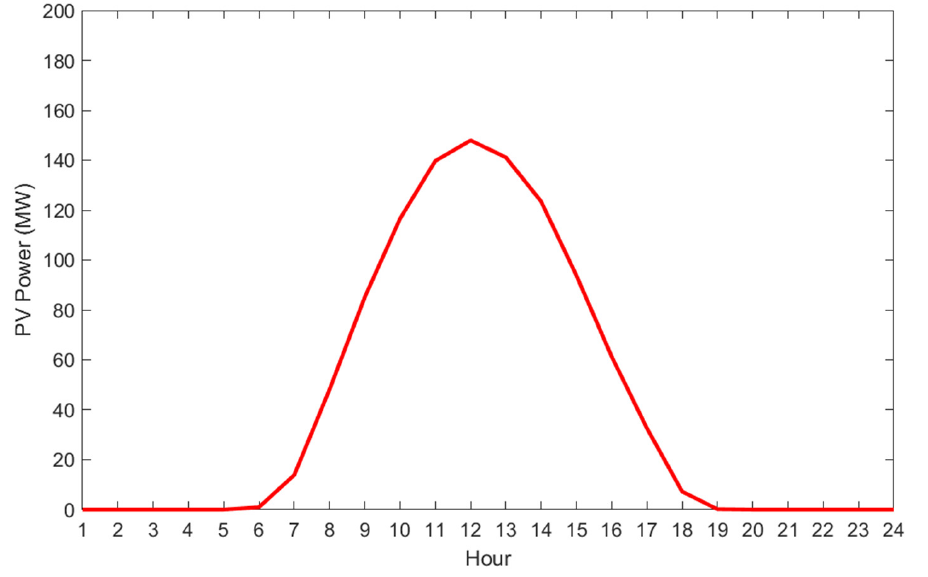
Figure 6. The daily curve of solar PV power generation. Table 1. Necessary parameters of the ESS for the calculation.